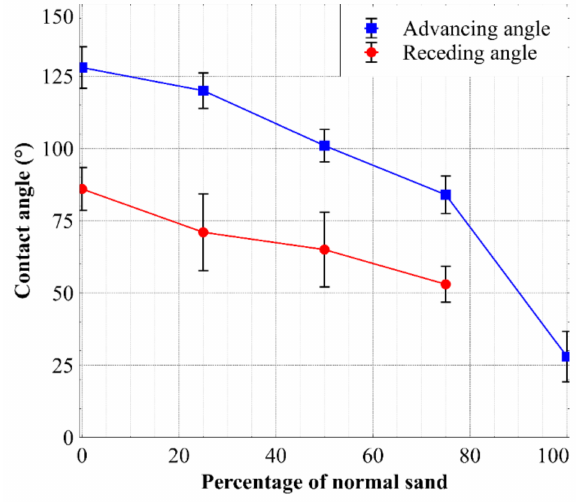
Figure 5. Advancing and receding angles measured for the sand and sand mixtures.